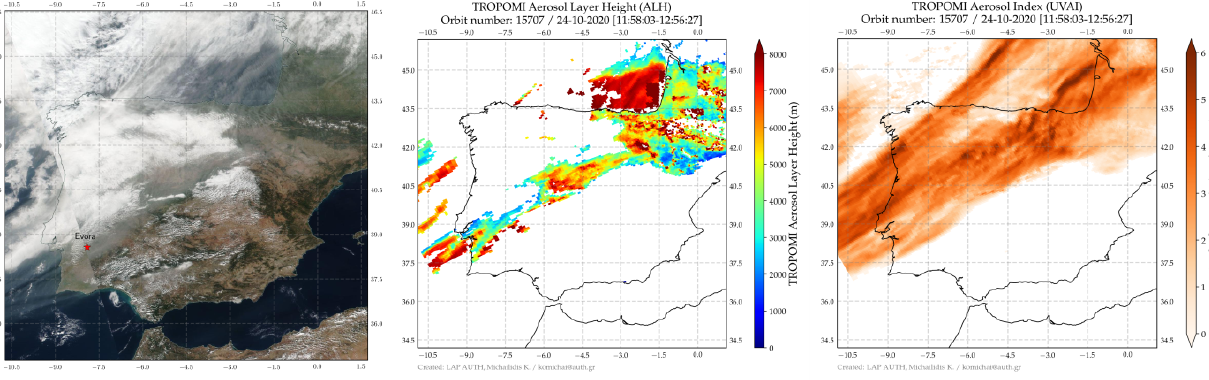
Figure 9. VIIRS Suomi-NPP true-colour image on 24 October 2020 over the Iberian Peninsula capturing the smoke plume (left). The red star indicates the position of the Potenza lidar station, TROPOMI ALH (middle) and UVAI (right) retrievals at 340 and 380nm. Missing ALH pixels are flagged by a cloud or have negative AI